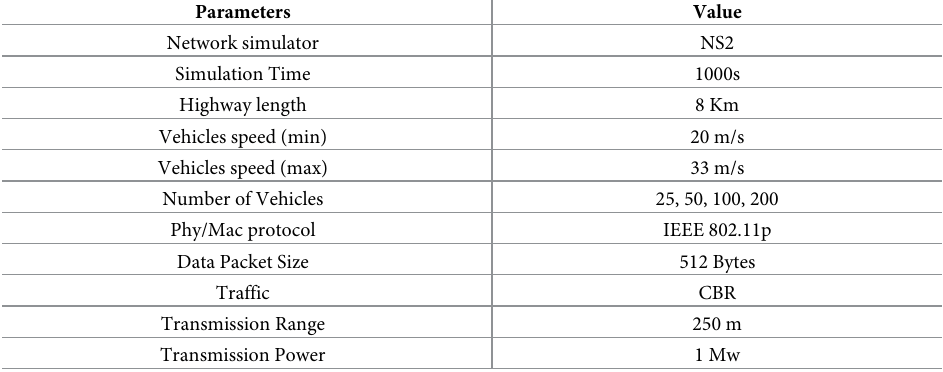
Table 2. Simulation